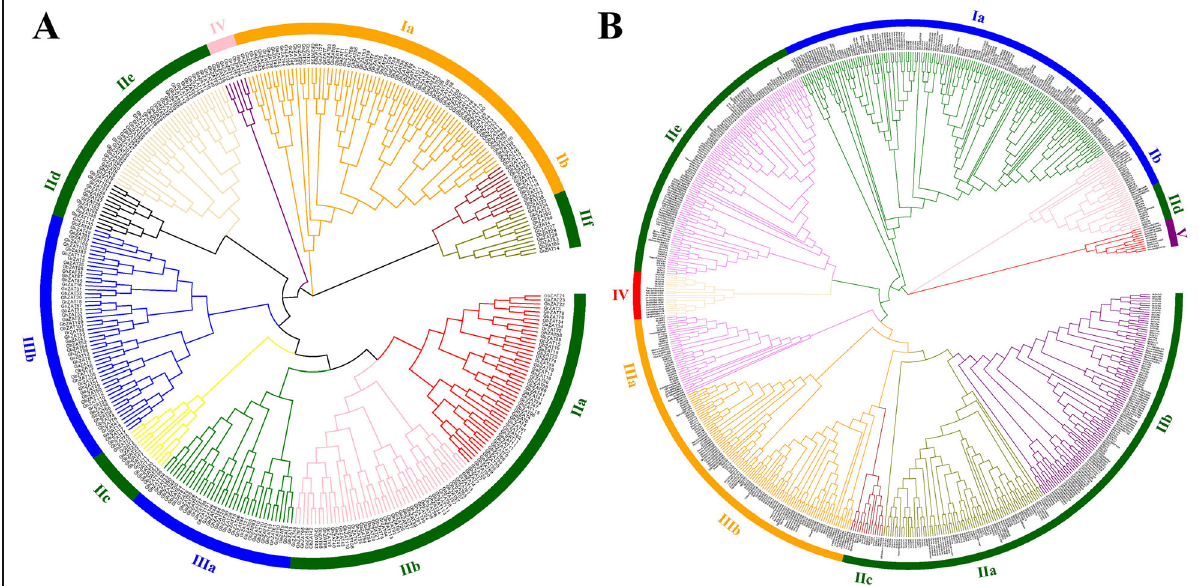
Fig. 2 Two rooted phylogeny trees constructed using MEGA-7 by the Neighbor-Joining (NJ) method. A: Phylogenetic relationship of the 384 identified ZAT genes from four cotton species; B: Phylogenetic relationship of the 662 identified ZAT genes from four cotton species and other seven